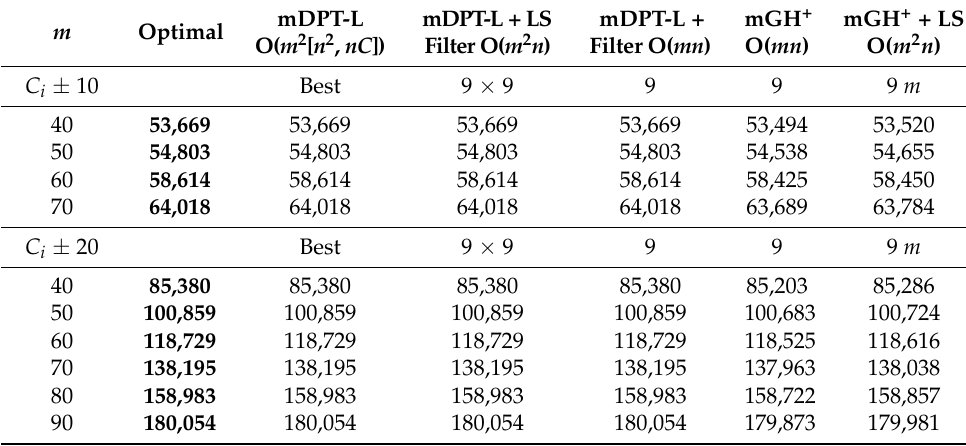
Table 9. Results (total profits) of datasets ( C ± 10, 20), n = 9000 ( m = 40–90).